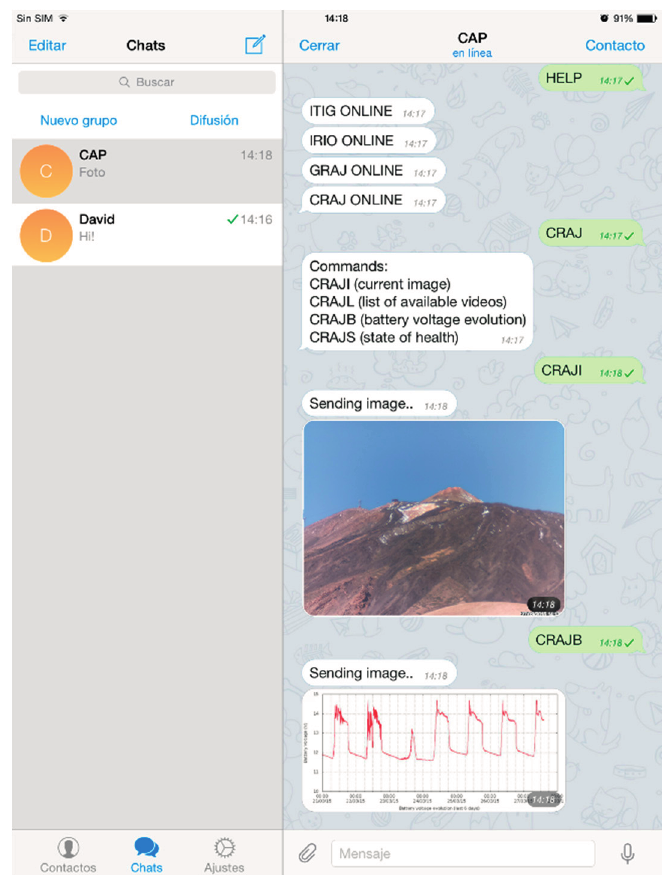
Figure 10. Querying the seasons via the Telegram instant messaging software using a smartphone. The last picture taken by the CRAJI command is sent and the battery status is checked with CRAJB command requests.